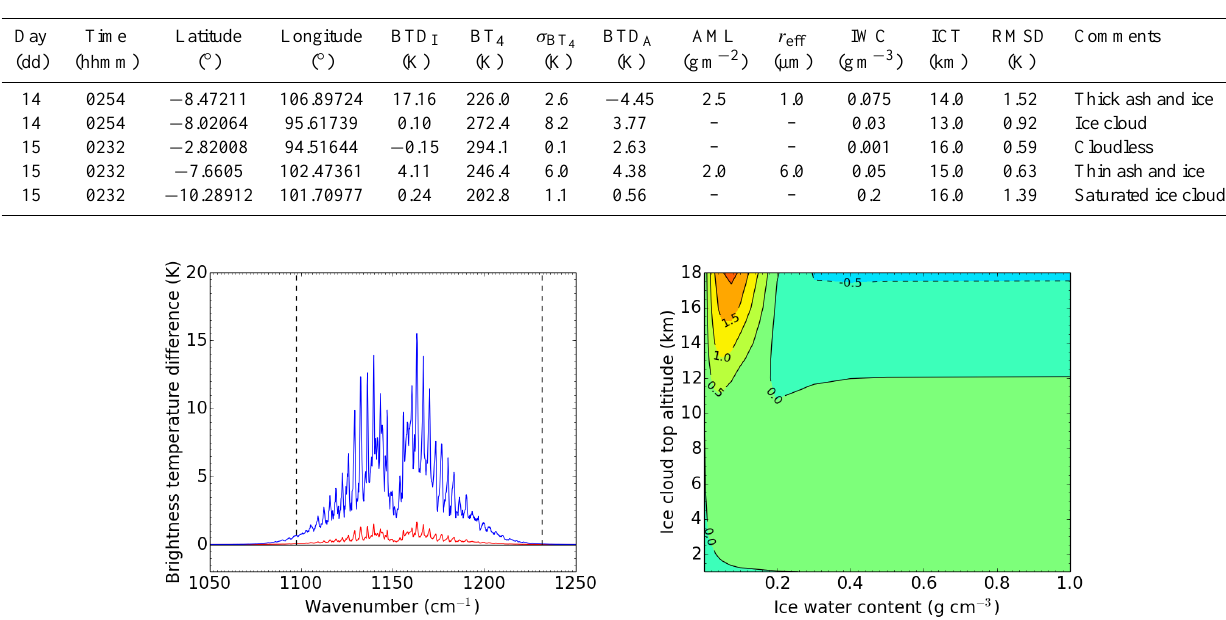
Table 1. Information pertinent to IASI data shown in Fig. 4. BTD I is the brightness temperature difference between the channels at 1231.5 and 1097.25cm − 1 . BT 4 is the mean AVHRR channel 4 brightness temperature for the AVHRR pixels covering the IASI footprint, and σ BT the standard deviation. The brigthness temperature difference between the means of AVHRR channels 4 and 5, BTD A = BT 4 − BT 5 is given in column 8. AML denotes the ash mass loading, r eff is the ash particle effective radius, IWC is the ice water content and ICT the ice cloud top height. RMSD is defined in Eq. (1).